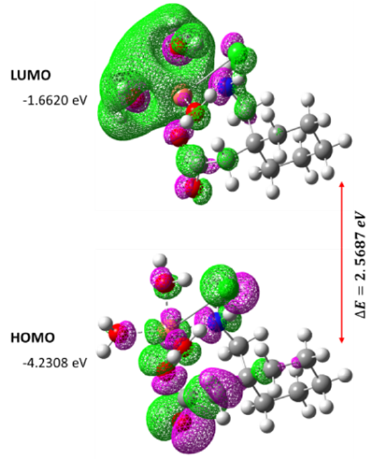
Figure 19. The spatial plot of HOMO and LUMO with their energy gap for the synthesized metal complex [Cu(II)–(Gpn)]. Table 8. The various other theoretical molecular parameters of the metal complex [Cu(II)–(Gpn)].